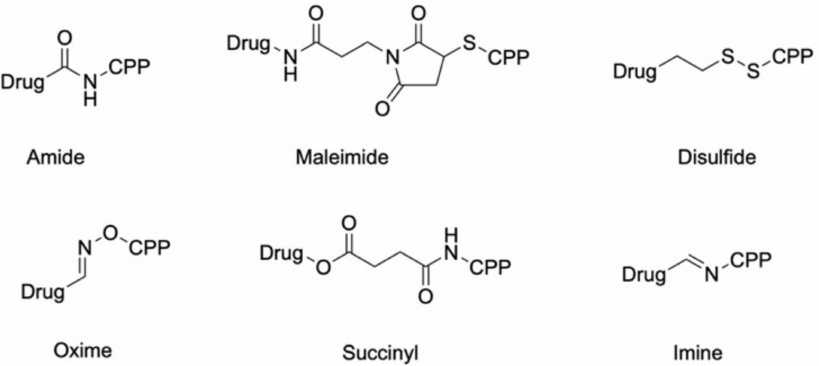
Figure 2. Exemplified are the different bonds formed between CPPs and drugs discussed within this